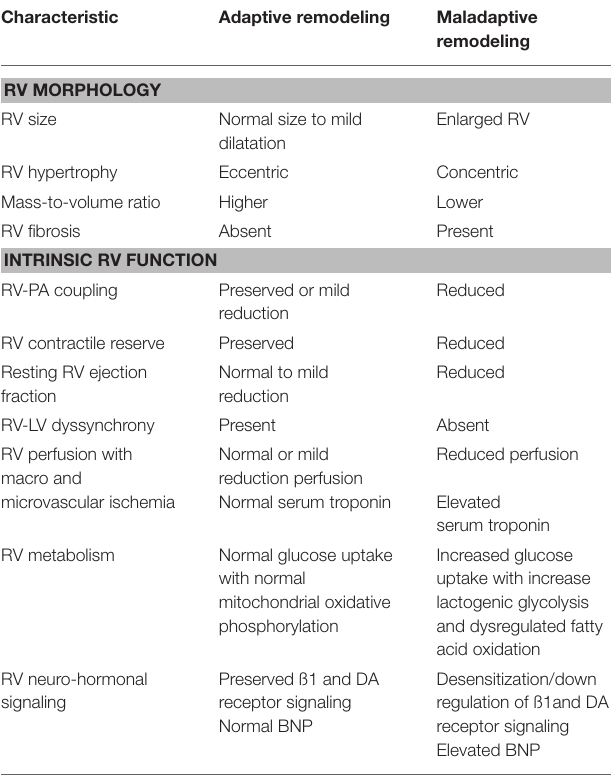
TABLE 1 | Characteristics of an adaptive and maladaptive remodeling pattern of the right ventricle in pulmonary hypertension.